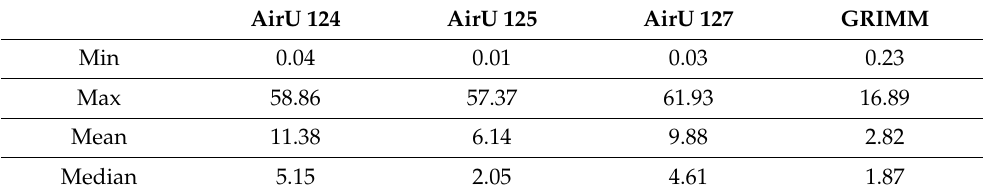
Table 2. Descriptive statistics for AirU and GRIMM comparison study (all values in µ g/m 3